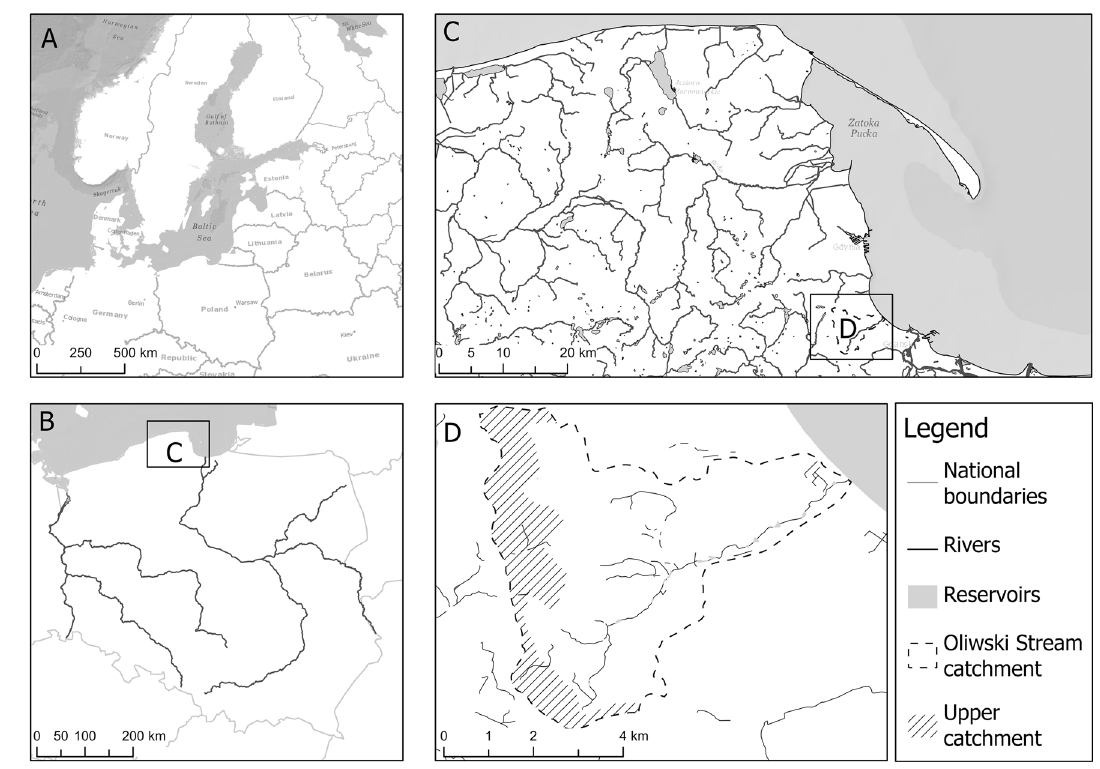
Fig. 2 Catchment of Potok Oliwski with plateau